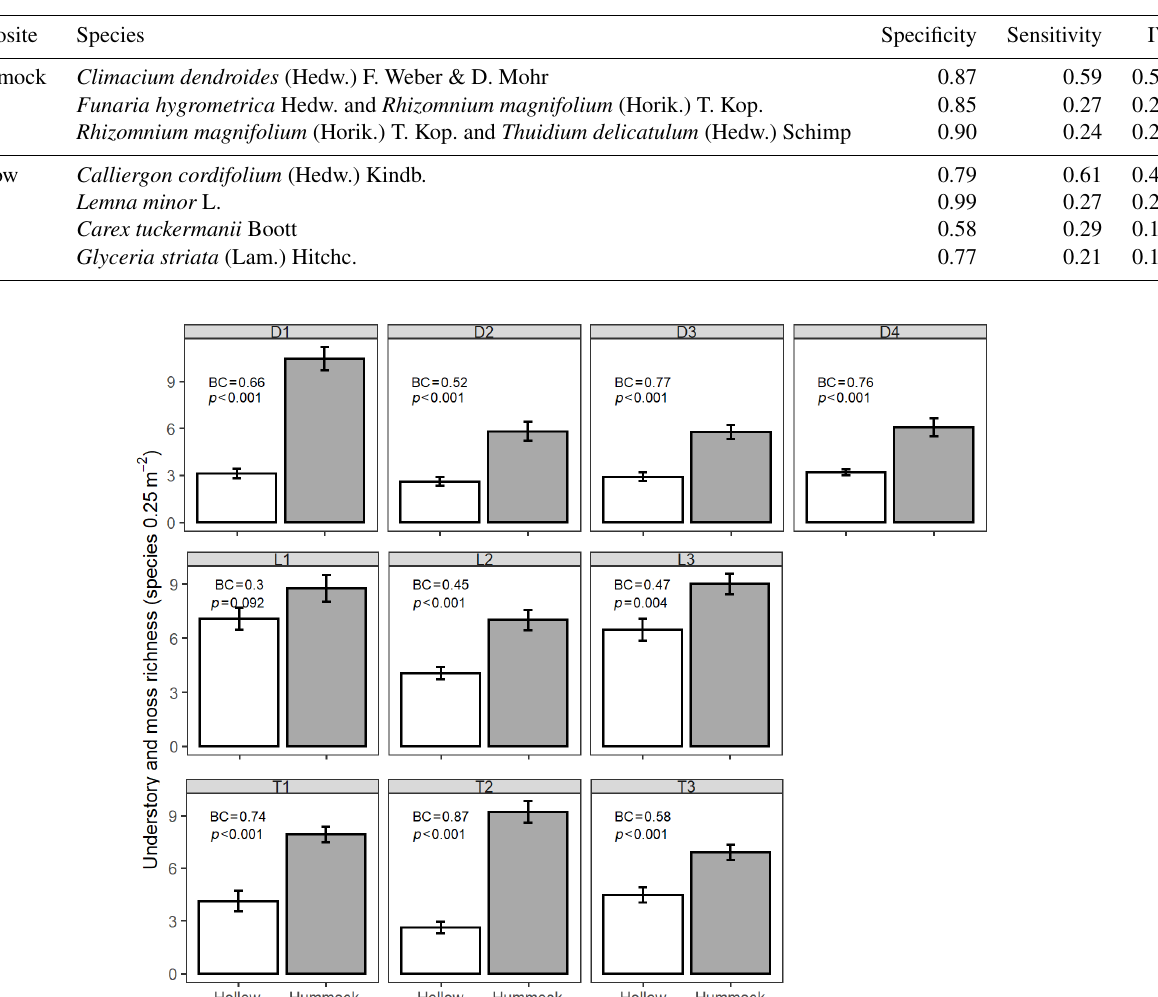
Figure 3. Combined understory vascular and moss richness hummock and hollow comparison. Text values indicate community dissimilarity indices and Welch’s two-sample t test results. BC text values indicate Bray–Curtis dissimilarity, with a 0–1 range, spanning identical (0) to completely dissimilar (1) vegetation